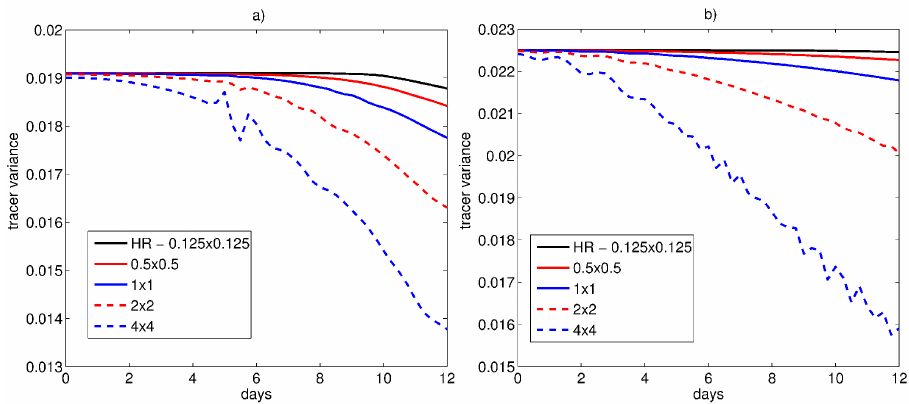
Fig. 4. Normalized tracer variance against time for the CAM-FV high resolution (HR) reference solution, and the reference solution averaged onto the coarse grids, for (a) test 1, and (b) test 2.